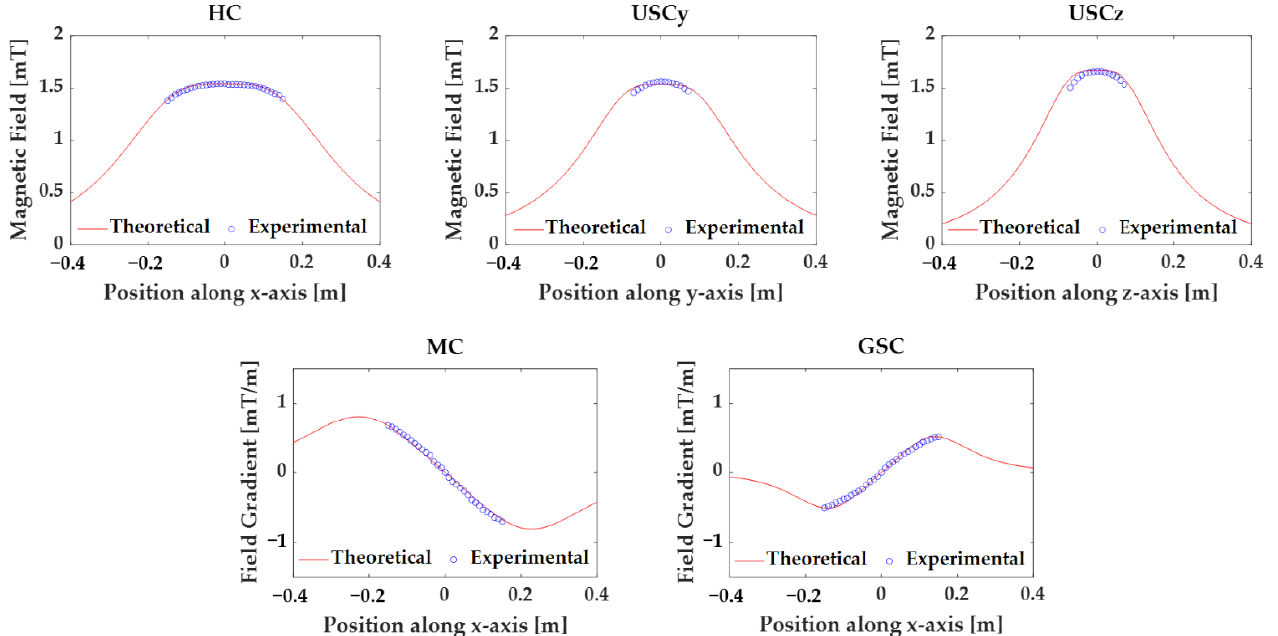
Figure 7. Calculated and measured magnetic field distribution along the axis of each coil when the current of 1 A was applied.